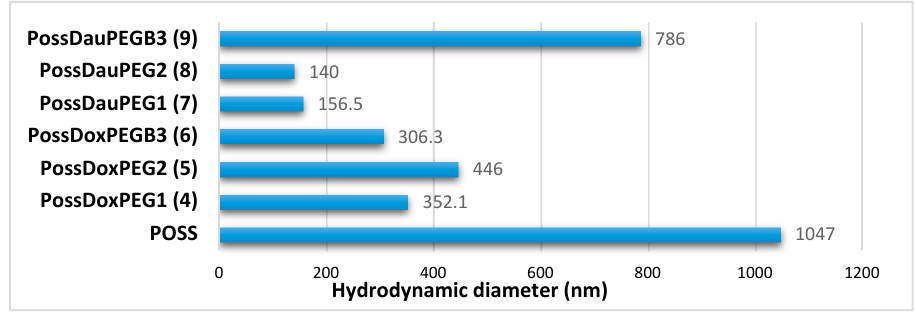
Figure 11. Comparison of hydrodynamic diameters of POSS(OH) 32 and conjugates 4 – 9 .